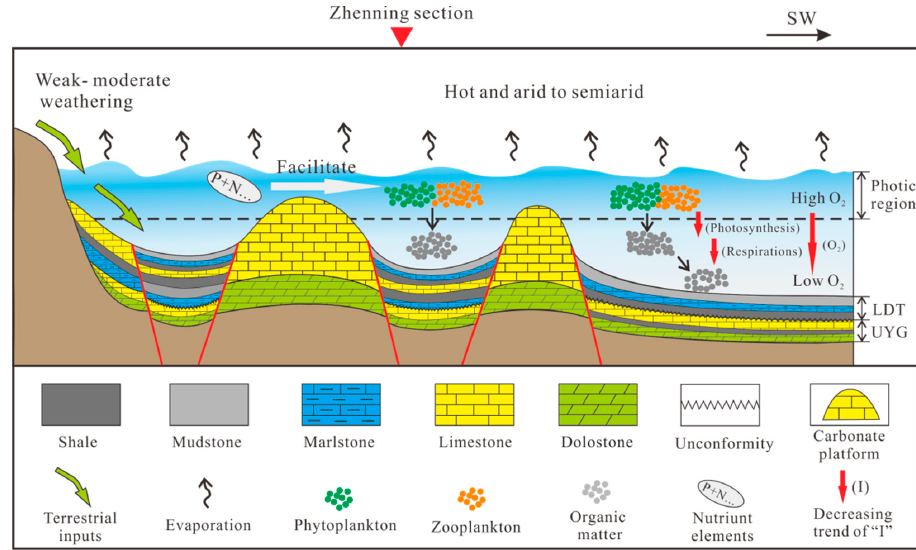
Figure 14. Model illustrating the factors that may have affected organic matter enrichment during the black rock series deposition in Southern Guizhou Depression. UYG and LDT represent the upper part of Yanguan Formation and the lower part of Datang Formation, respectively.